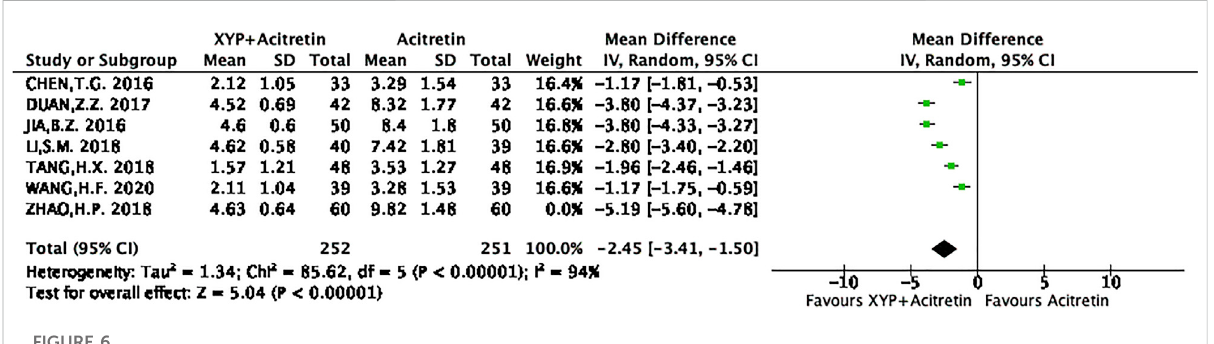
FIGURE 6 Forest plots showing the sensitivity analysis of PASI score.